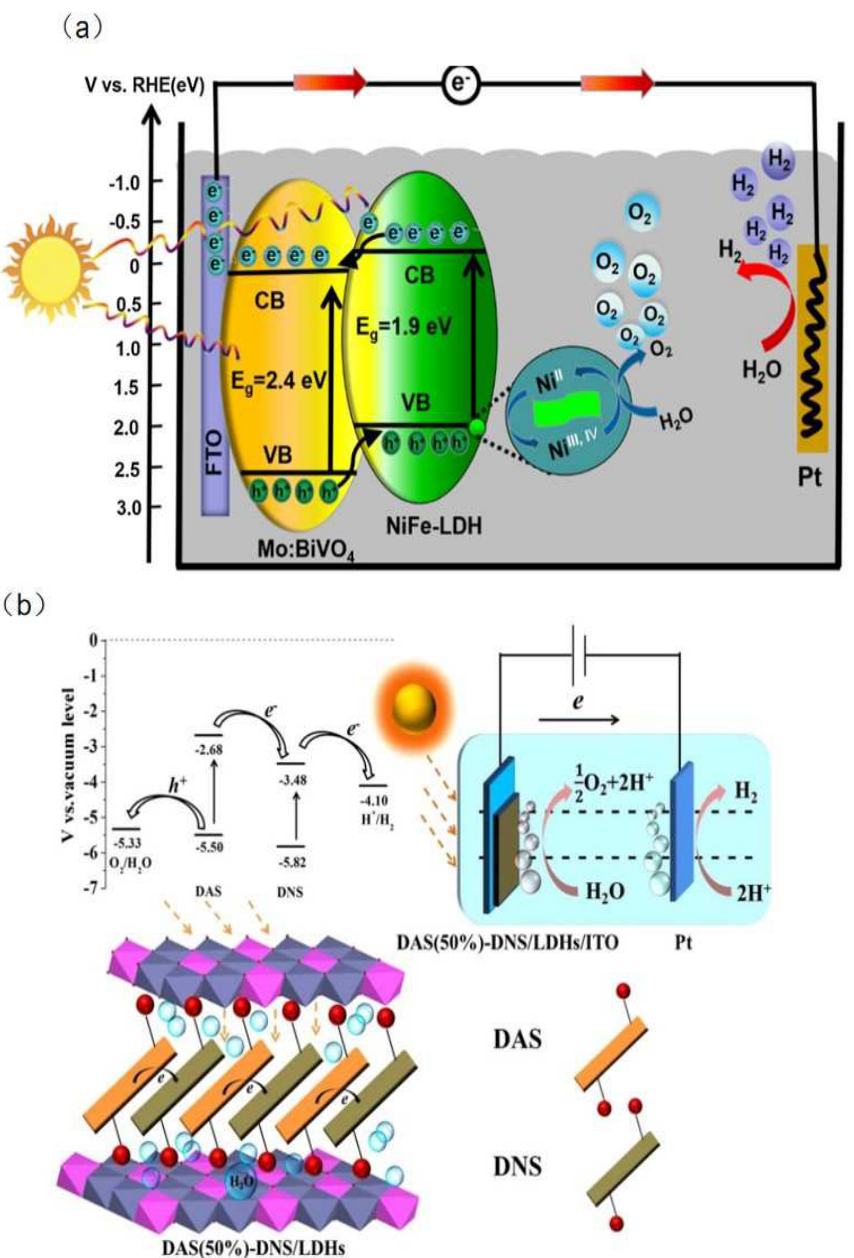
Figure 3. ( a ) PEC water splitting mechanism using the NiFe−LDH/Mo−BiVO 4 heterostructure pho- toanode [45]. Copyright 2018 Elsevier. ( b ) The possible photo−generated charges transfer mecha- nism of DAS (50%)−DNS/LDHs photoanode [47]. Copyright 2015 Springer